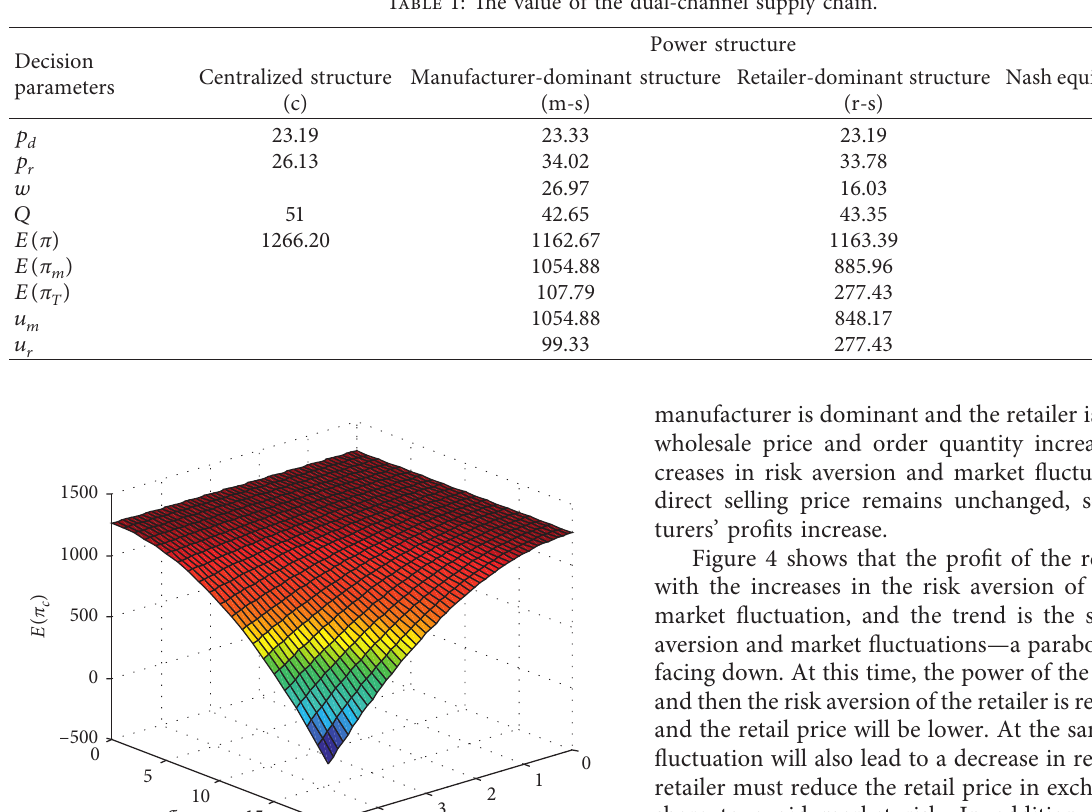
Table 1: The value of the dual-channel supply chain.